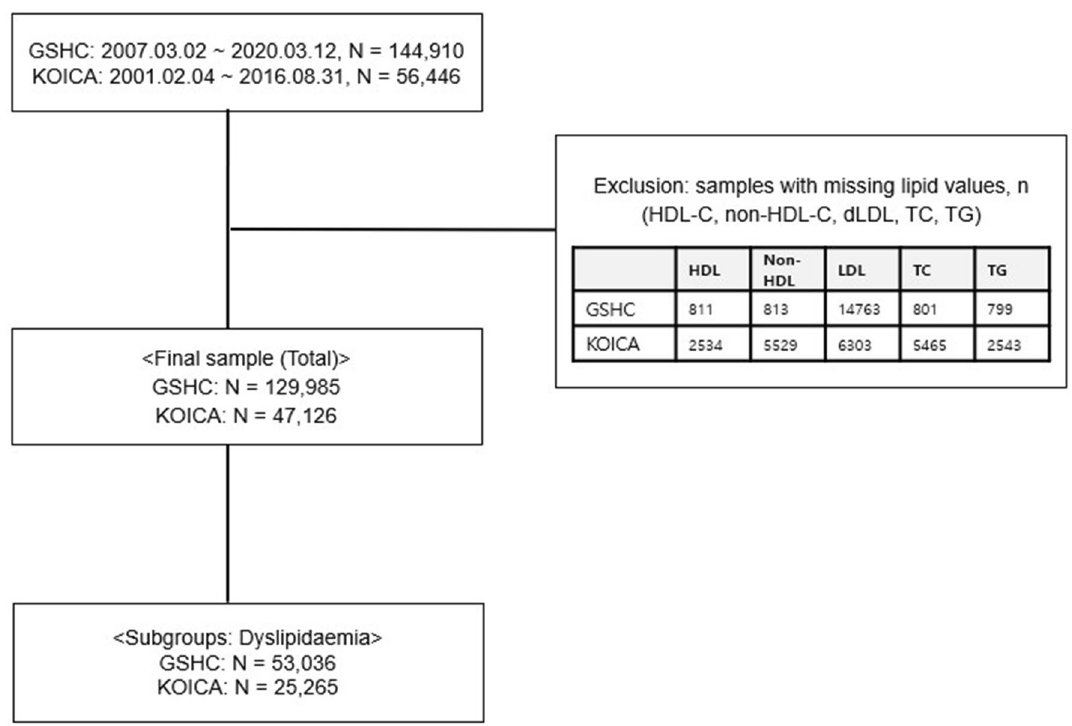
Figure 1. Flowchart of study design. N number; HDL-C high-density lipoprotein cholesterol; Non-HDL-C non-high-density lipoprotein cholesterol; TC total cholesterol; LDL-C low-density lipoprotein cholesterol; dLDL direct LDL-C; TG triglyceride; GSHC Gangnam Severance Hospital Check-up; KOICA Korea Initiatives on Coronary Artery